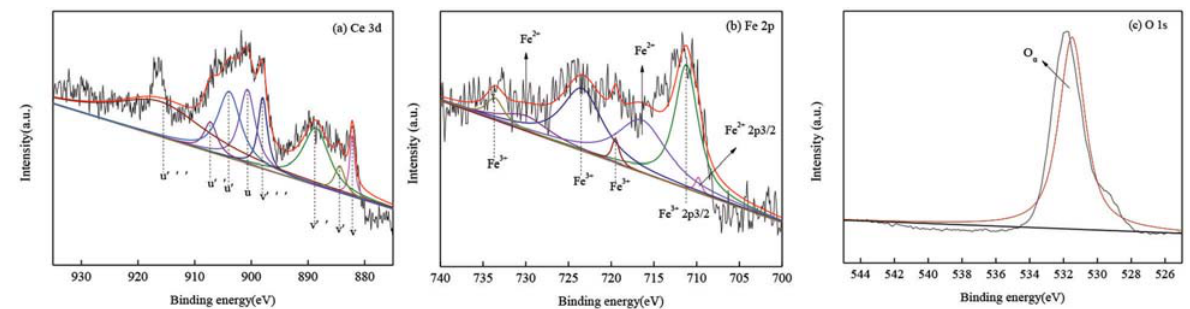
Figure 16: XPS diagram of Sample 2: (a) Ce 3d, (b) Fe 2p, and (c) O 1s.